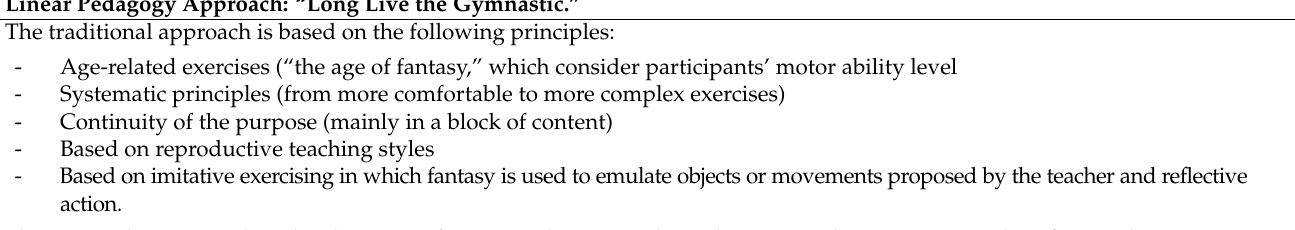
Table A2. An example of the structured practice prevalently based on linear pedagogy, as used in teaching